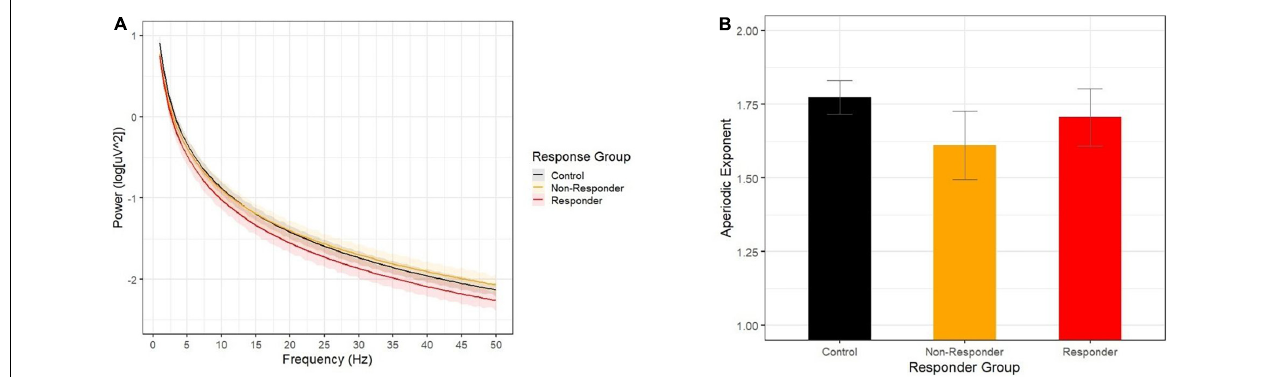
FIGURE 2 | (A) Aperiodic slopes by response group show that the non-responder group (yellow) showed a flatter decline across 1-50 Hz than did the control group (black), while the responder group (red) did not differ from controls. (B) Aperiodic slope exponents by response group.